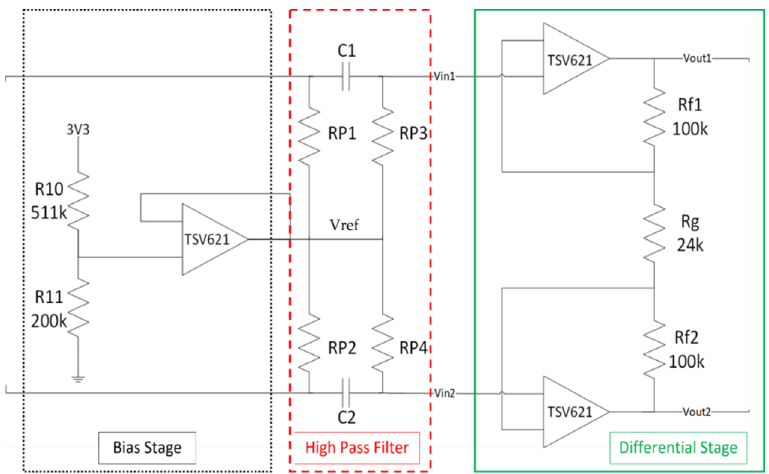
Figure 2. Pre-amplifier